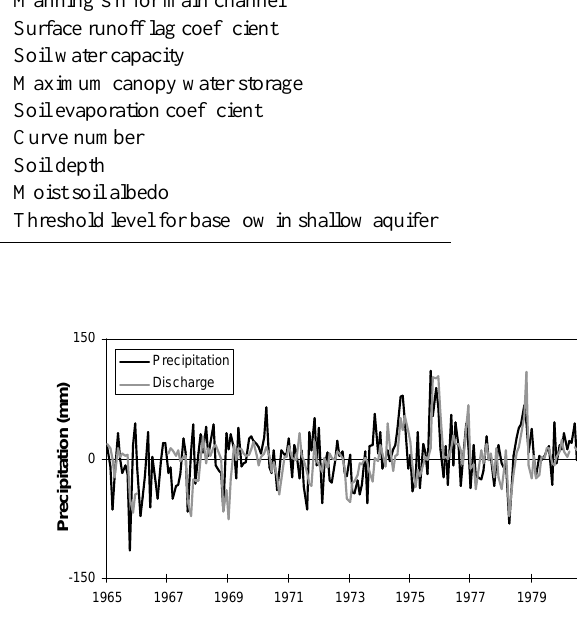
Fig. 3. Comparison of difference in monthly precipitation between CRU TS 3.0 and station-based records with modelled-observed dif- ferences in the discharge of the River Mitano for the period 1965–